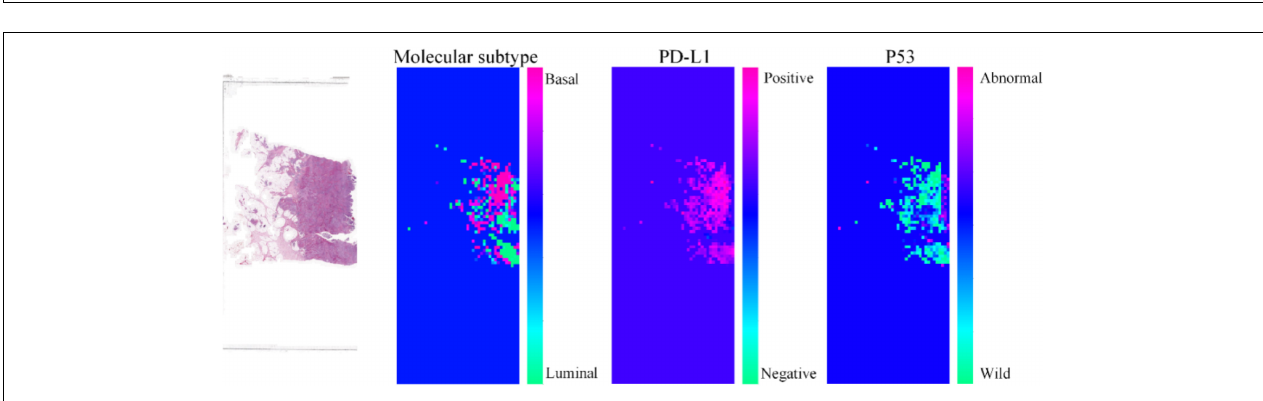
FIGURE 5 | Heatmaps of the same pathological image predicted by our proposed method for molecular subtype, PD-L1 status, and p53 status.